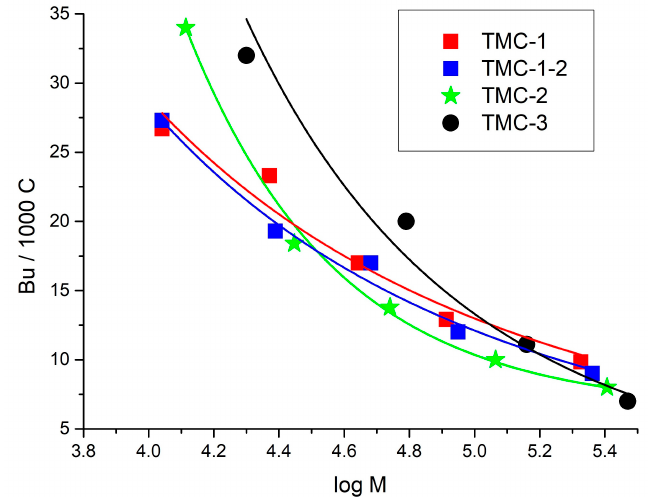
Figure 3. The content of butyl branching in the fractions of copolymers produced on the catalysts of different compositions. Table 3. Data on the molecular weight characteristics of individual fractions and the content of branchings in these fractions for copolymers produced over TMC-1, TMC-1-2, TMC-2, and TMC-3 catalysts. Exp.